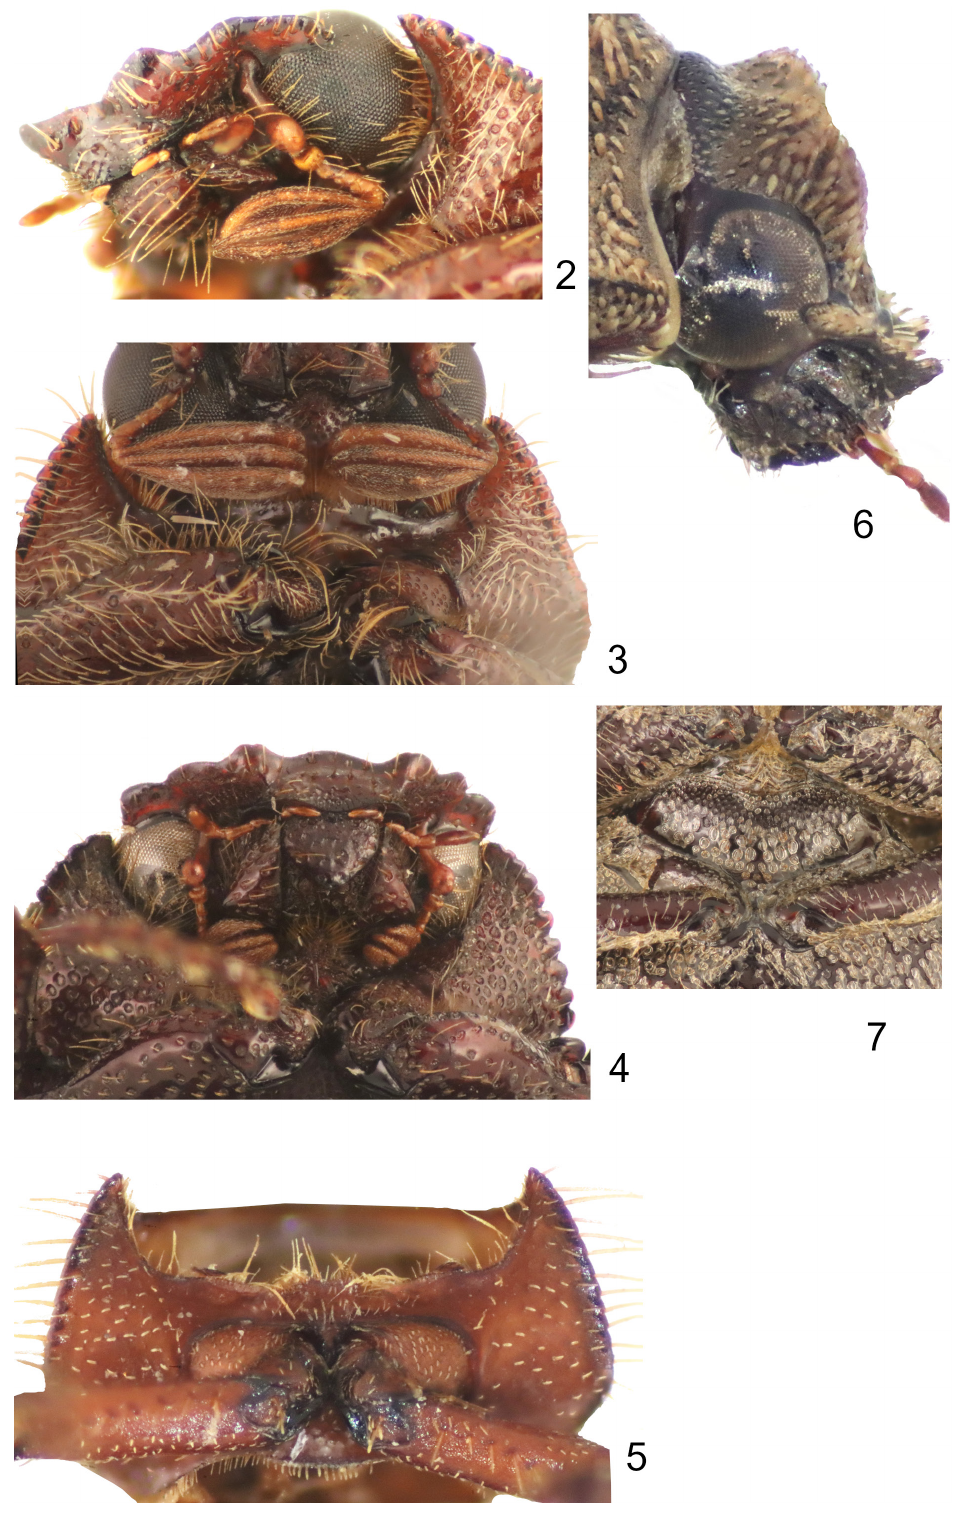
Figs 2–7. Maechidiini Burmeister, 1855 features. 2 . Maechidius esau Heller, 1914, head, ventro-lateral view. 3 . Same, head and pronotum, ventral view. 4 . Maechidius sp., same. 5 . M. bilobiceps (Fairmaire, 1877) comb. nov., prosternum and pronotal hypomera, ventral view (BMNH). 6 . M. weigeli sp. nov., paratype, ♂, head, lateral view (NME). 7 . M. spurius Macleay, 1819, mesoventrite. Not to